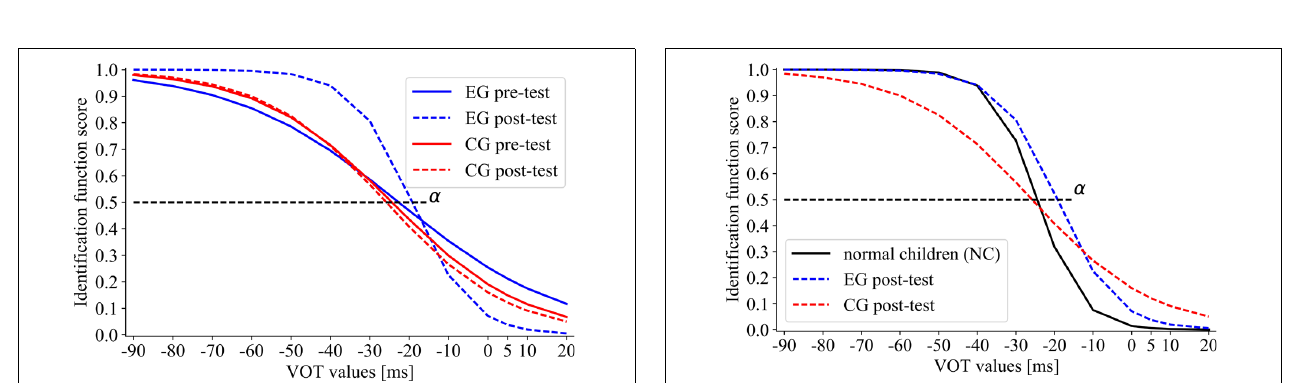
FIGURE 6 | The voiced identification score for the presented VOT spectrum in NC and SLI indicating the similar ranges of voiced/unvoiced categories in both groups with poorer performance in SLI than in NC.